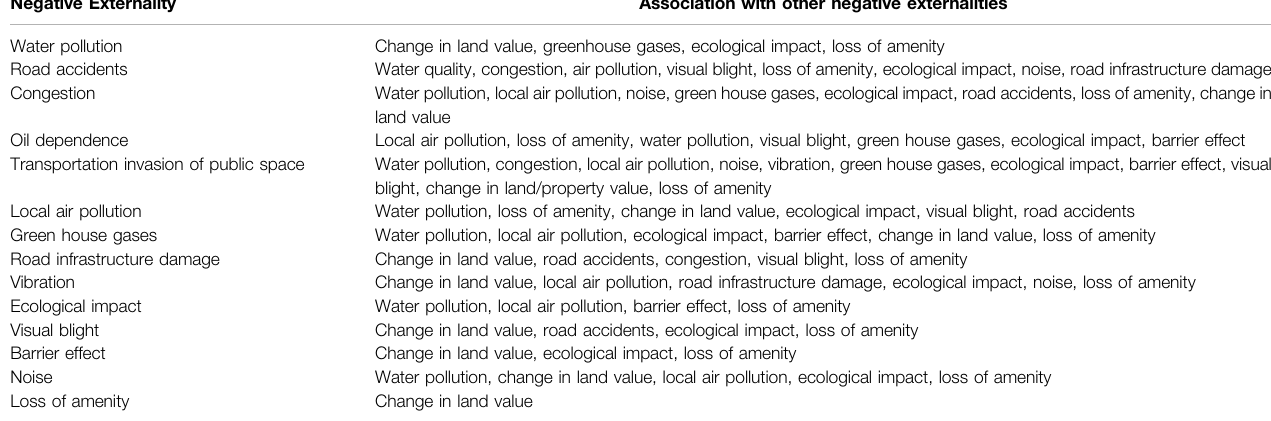
TABLE 1 | Freight transport externalities and their inter-se interlinking (Chatziioannou et al., 2020). Negative Externality